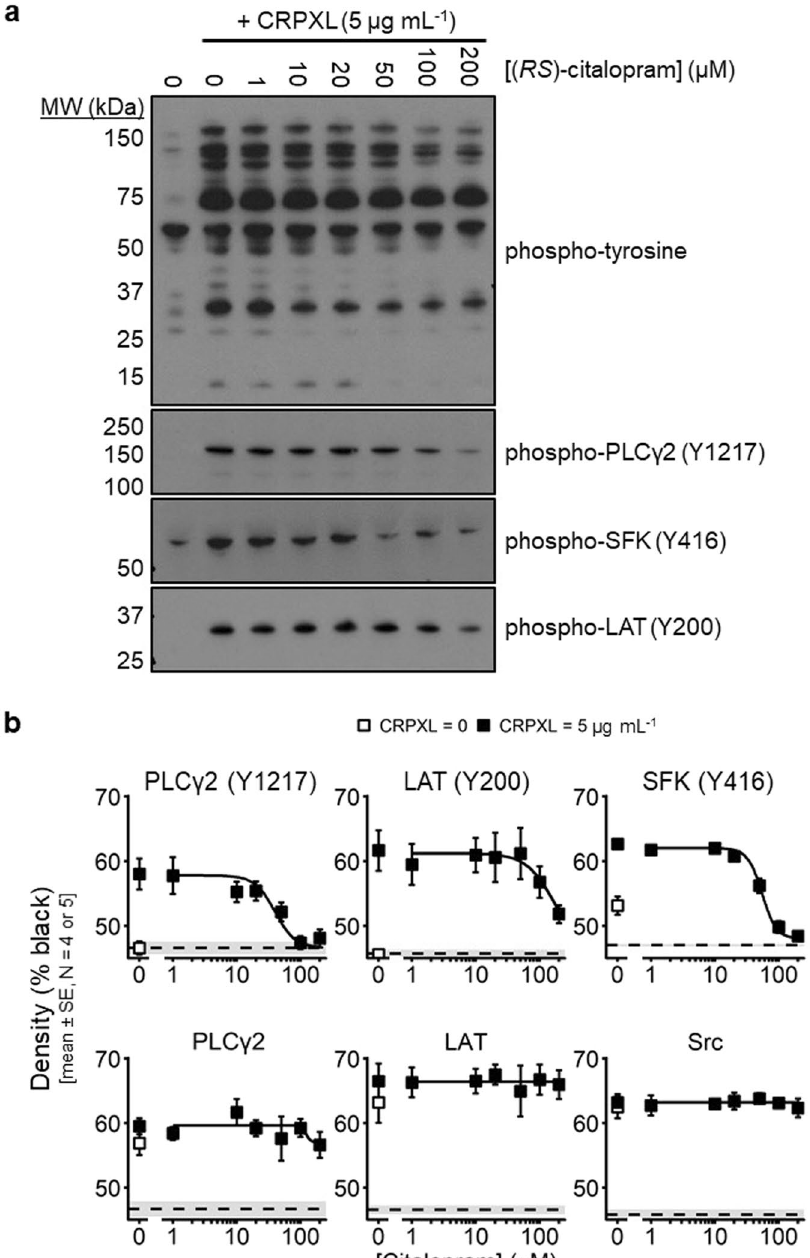
Figure 5. Whole cell tyrosine phosphorylation (4G10) and site-specific phosphorylation of Src family kinases (SFK), LAT and PLC γ 2. Platelets were stimulated with 5 µ g mL − 1 CRPXL for 6 min under aggregometry conditions in the presence of GR 144053 (2 µ M) to prevent aggregation and facilitate solubilisation of protein. ( a ) Images from non-blinded pilot experiments show the effect of ( RS )-citalopram on whole cell tyrosine phosphorylation and site-specific phosphorylation of PLC γ 2, SFK and LAT. The whole cell tyrosine phosphorylation blot is one of two repeats. The phospho-specific blots are from additional pilot experiments. Images have been cropped from four different blots. Images of full-length blots from these experiments are presented in Supplementary Fig. S1. ( b ) Densitometric quantification from blinded and randomised experiments measuring site-specific phosphorylation of PLC γ 2 (N = 5), SFK (N = 4) and LAT (N = 5) in resting or stimulated platelets. Blots are shown in Supplementary Figs. S2 and S3. Dashed lines (mean) and grey area ( ± SE) indicate background signal on the developed X-ray films. Lower panels represent total protein levels from the same samples. Concentration-responses were modelled using NONMEM 7.3 to accommodate random between experiment variability often associated with Western Blotting. Confirmation of the phosphorylation response was performed using likelihood ratio tests by comparing the following statistical hypotheses: H 0 : Max = Min and H 1 : Max ≠ Min . Results were: phospho-PLC (Y1217), P = 2 × 10 − 13 ( χ 2 = 65.1, df = 4); phospho-SFK (Y416), P = 7 × 10 − 25 ( χ 2 = 115.7, df = 3); phospho-LAT (Y200), P = 4 × 10 − 10 ( χ 2 = 49.8, df =